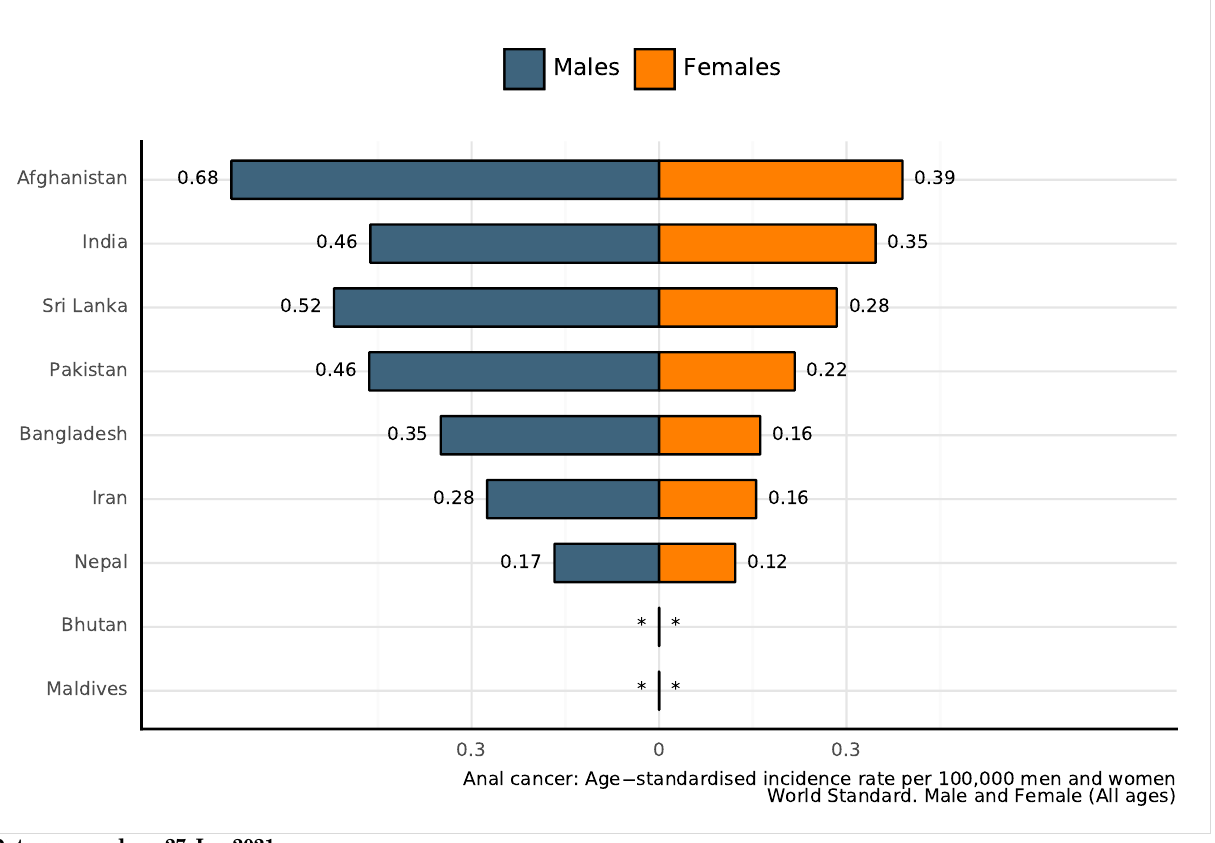
Figure 76: Age-standardised incidence rates of anal cancer of India (estimates for 2020)